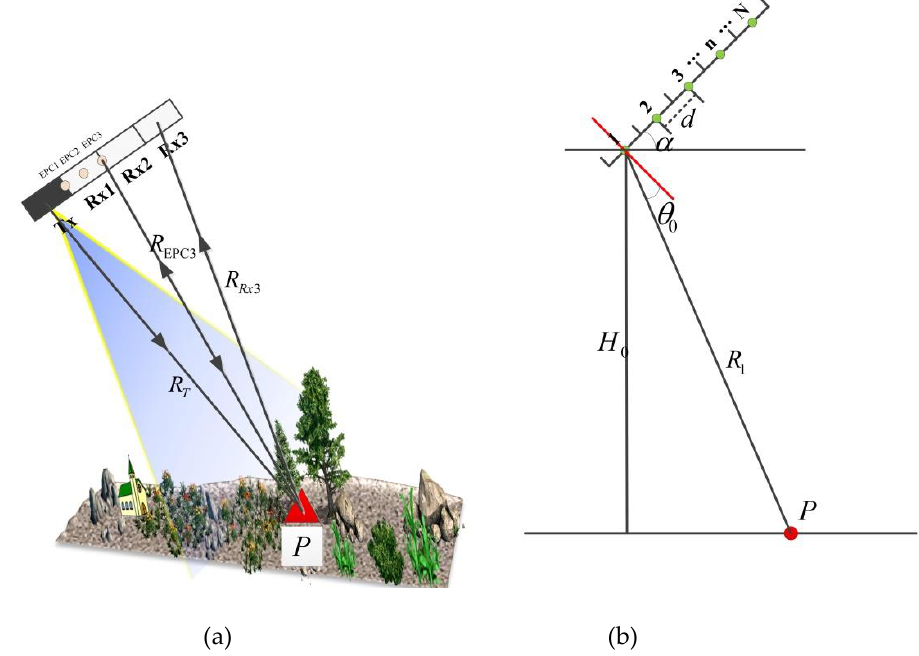
Figure 1. Geometric model of DBF-SAR in elevation. ( a ) EPC model. ( b ) DBF-SAR